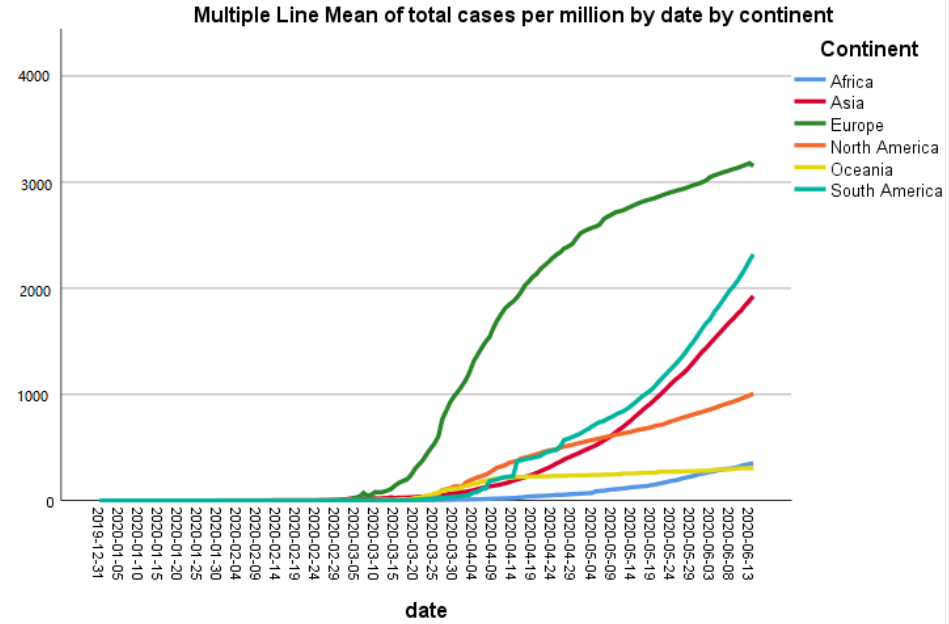
Figure 1. Trend of cumulative new cases standardized for population (per million) by continent.